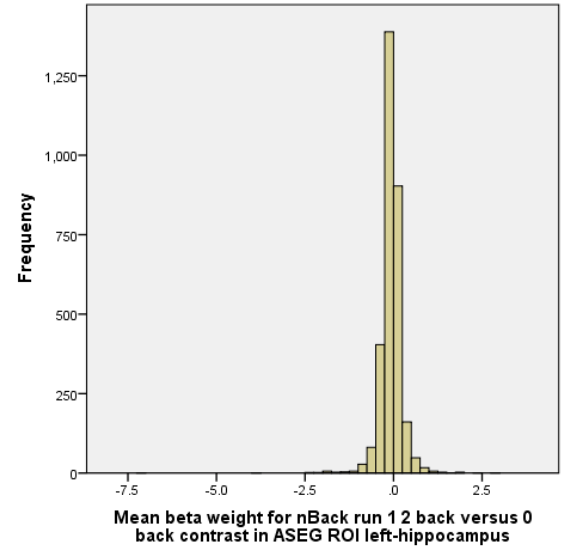
Figure A1. Histogram of hippocampus activation during the N-Back memory test.